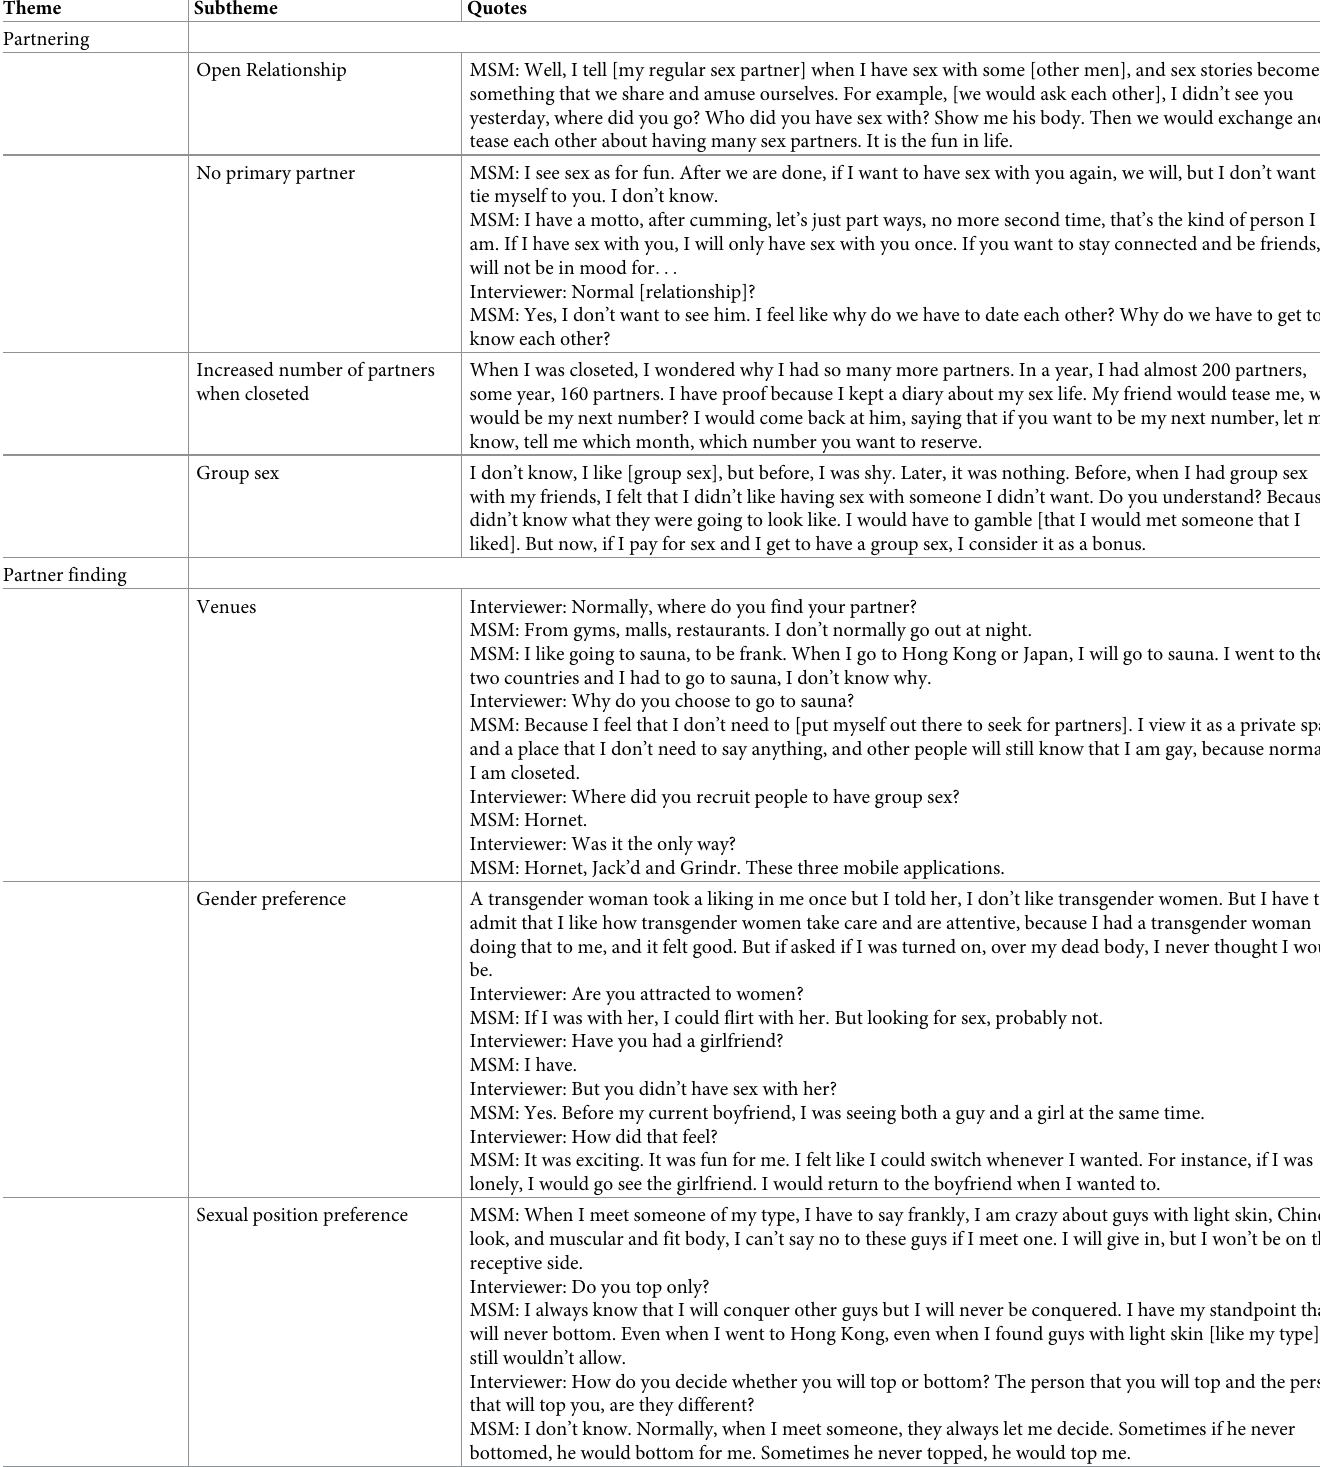
Table 2. Themes for MSM participants.